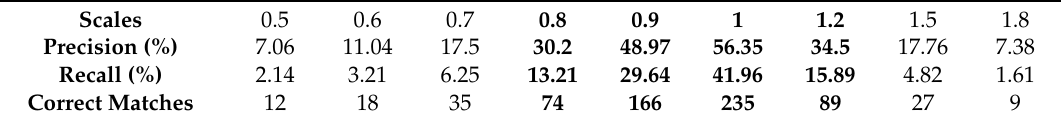
Table 9. The precision, recall, and correct matches of different